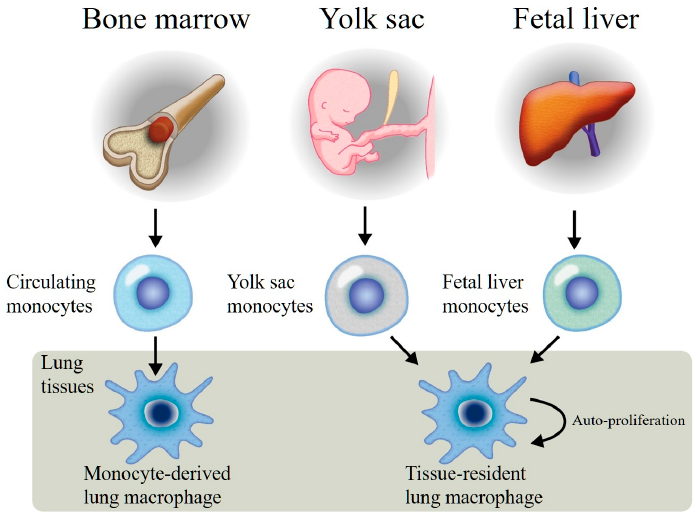
Figure 1. Monocyte-derived lung macrophages originating from bone marrow pluripotential stem cells, released into the circulating blood, and recruited into the lung tissues. These macrophages have limited proliferation functions. Tissue-resident lung macrophages are generated from both the yolk sac and fetal liver, recruited into the lungs during the early stage of lung development, and become resident lung macrophages with auto-proliferation functions.